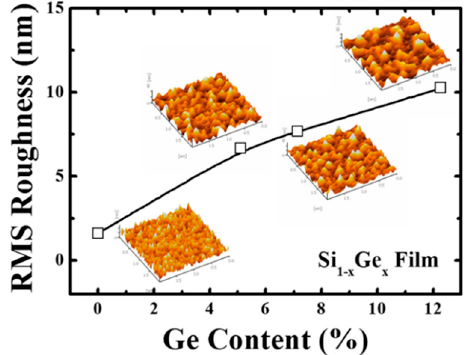
Figure 5. Surface morphology and root-mean-square (RMS) roughness of the poly-Si 1 − x Ge x films as a function of Ge content. The surface roughness increases with increasing Ge content.